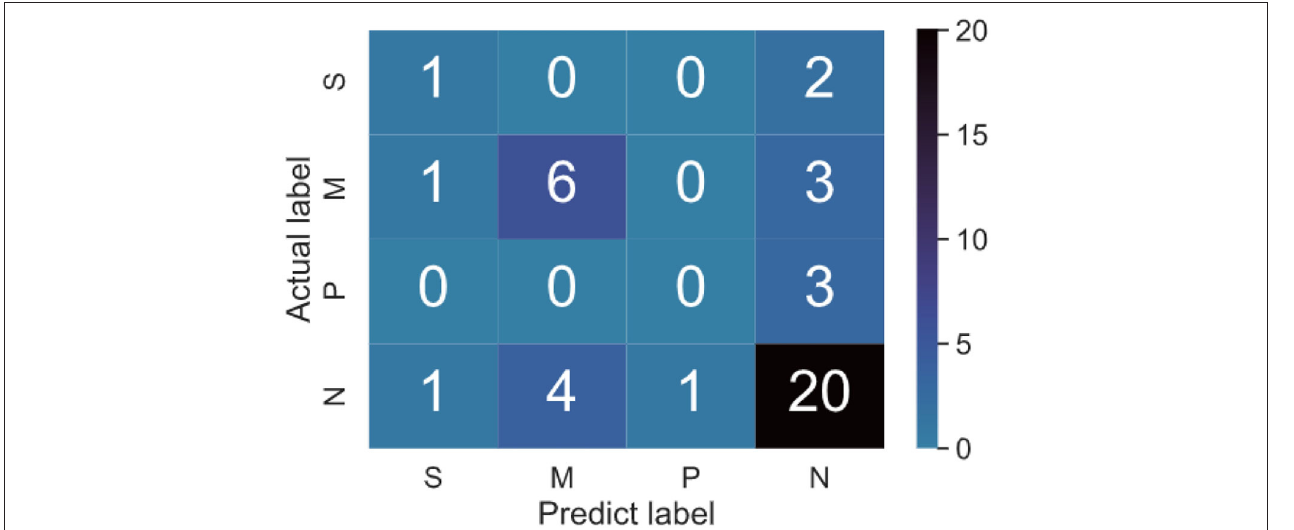
FIGURE 8 | Confusion matrix of binary classification testing set. There are four groups in the multi classification dataset. Four classes contain S-severe, M-Medium, P-probable, and N-none depression. For example, 4 in N rows and M columns in the figure indicates that the real label is none depression, and the predicted label is Medium